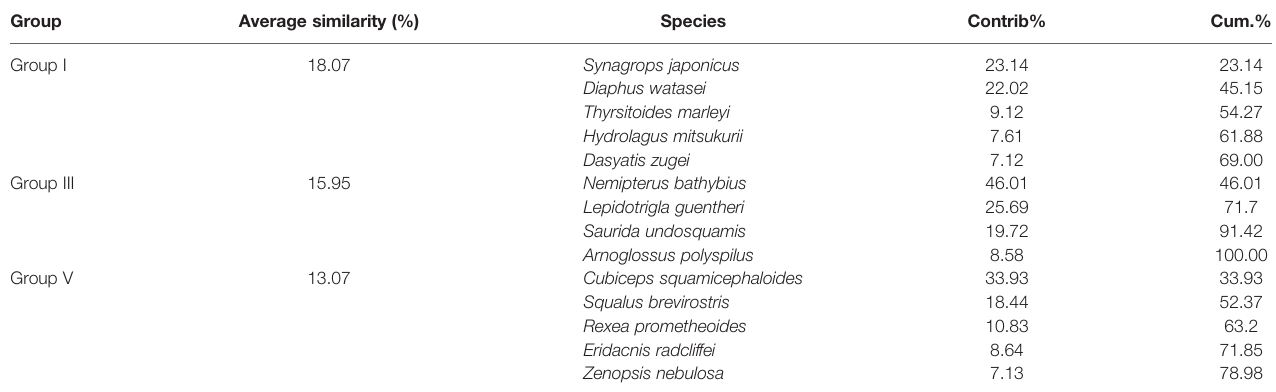
TABLE 2 | Intra-group average similarity of fi sh composition and top fi ve contributing species over the NCSSCS. Group Average similarity (%) Species Contrib% Cum.% Group